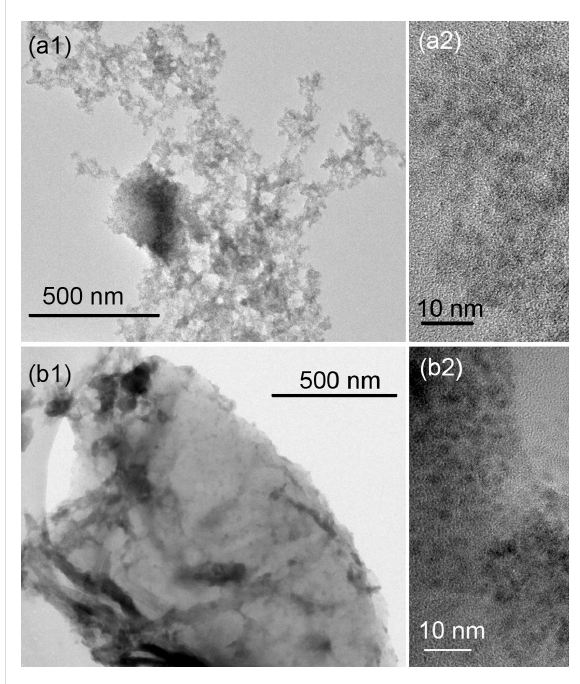
Figure 4: Morphologies of rGO(0)–CeO 2 (a1: TEM, a2: HRTEM) and rGO(0.05)–CeO 2 (b1: TEM, b2: HRTEM). N 2 adsorption–desorption results for the rGO–CeO 2 compos- ites with different proportions of rGO after solvothermal treat- ment are shown in Figure 5, left. Only rGO(0.2)–CeO 2 is meso- porous, according to the IUPAC classification, while the others contain mainly micropores and a small portion of mesopores. This can also be seen from the pore size distribution (Figure 5, right). rGO(0.2)–CeO 2 has an average pore size of 4.8 nm, while the other samples have smaller pore size in the range